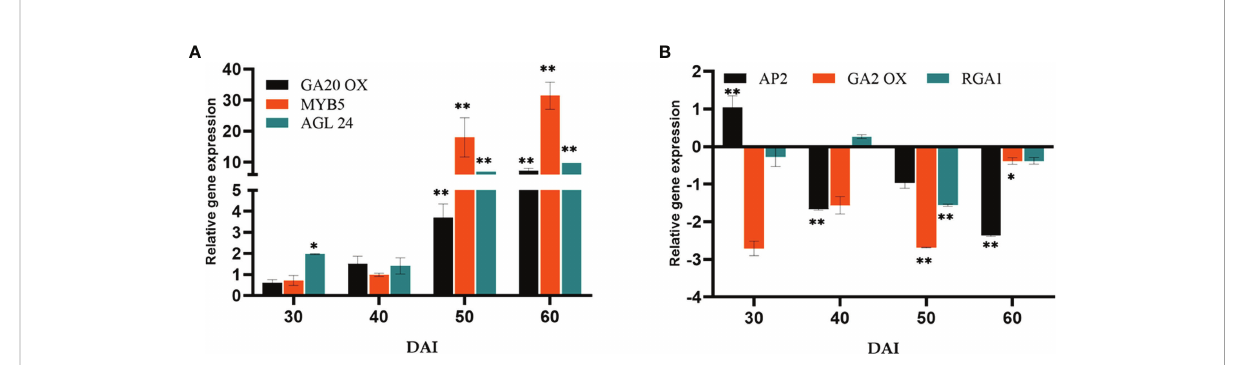
FIGURE 6 Relative gene expression of representative genes in the gibberellic acid biosynthesis pathway (A) GA20OX , MYB5 & AGL24 (B) AP2 , GA2OX & RGA1, responsible for fl owering response. The samples were isolated for qRT-PCR at 30, 40, 50 and 60 DAI. Error bars shows ±SEs of three biological replicates. Signi fi cance of the values were determined using student t - test, ** P< 0.01 and * P <